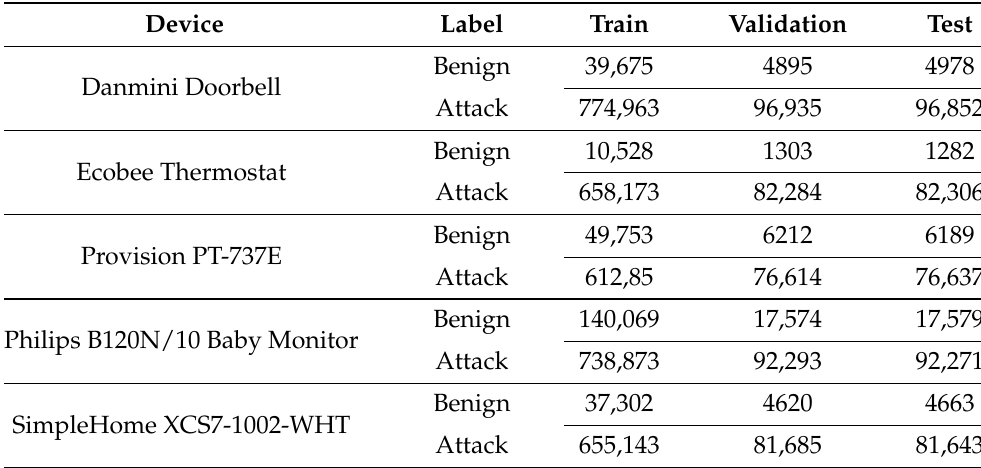
Table 3. Count Statistics for each device type of the N-BaIoT dataset.